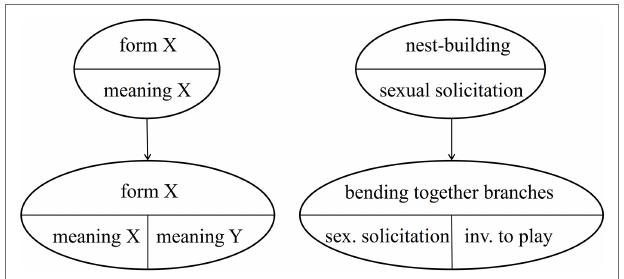
FIGURE 3 | Partial group-specific semantic